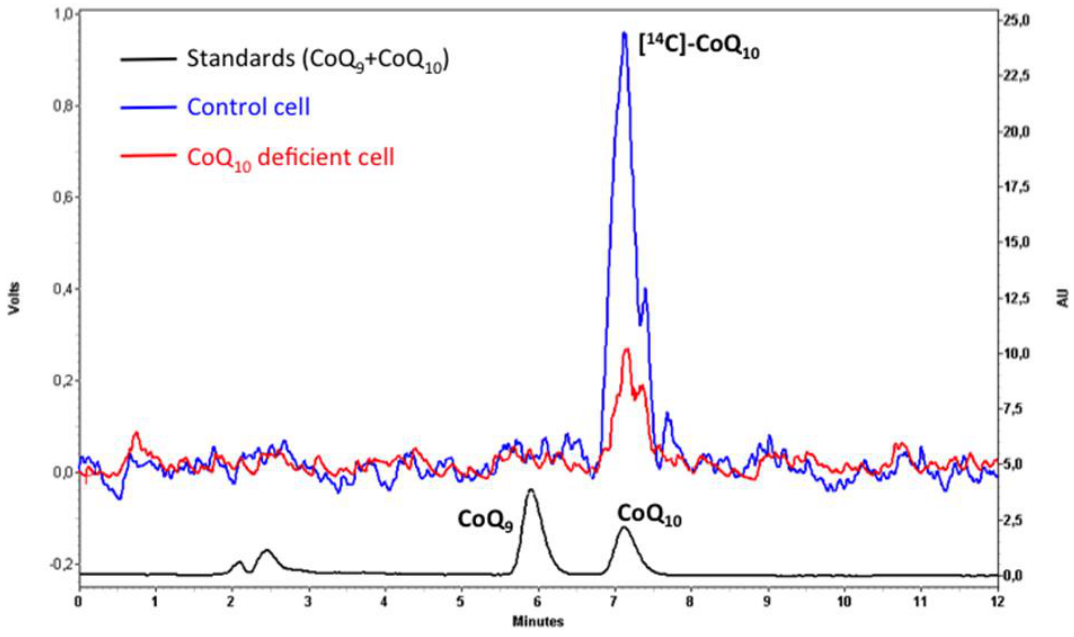
Figure 2. HPLC elution profile of lipid extracts from human fibroblasts cultured with the radiolabeled precursor 14 C- p- HB. Patient pathological profile (red plot) shows that CoQ 10 is clearly diminished compared to control cells from healthy humans (blue plot). Left Y-axis shows the radio-flow detector scale (volts). Right Y-axis shows the UV-detector scale (absorbance units) for a standard pool of CoQ 10 and CoQ 9 (black plot). Notice that the only peak detected in this analysis corresponded with CoQ 10 .